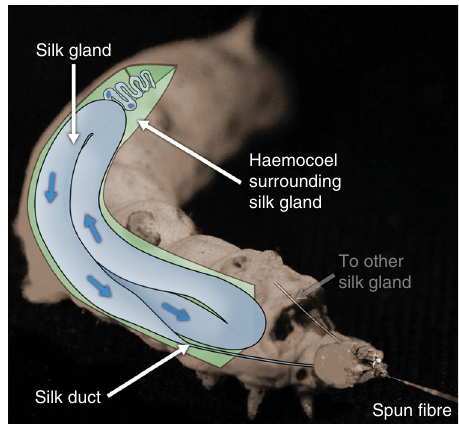
Fig. 1 Anatomical overview of the B. mori silk gland. Diagram depicting the silk spinning apparatus of B. mori , highlighting the gland ( blue ) surrounded by the haemocoel ( green ). Direction of silk fl ow during spinning is indicated by the blue